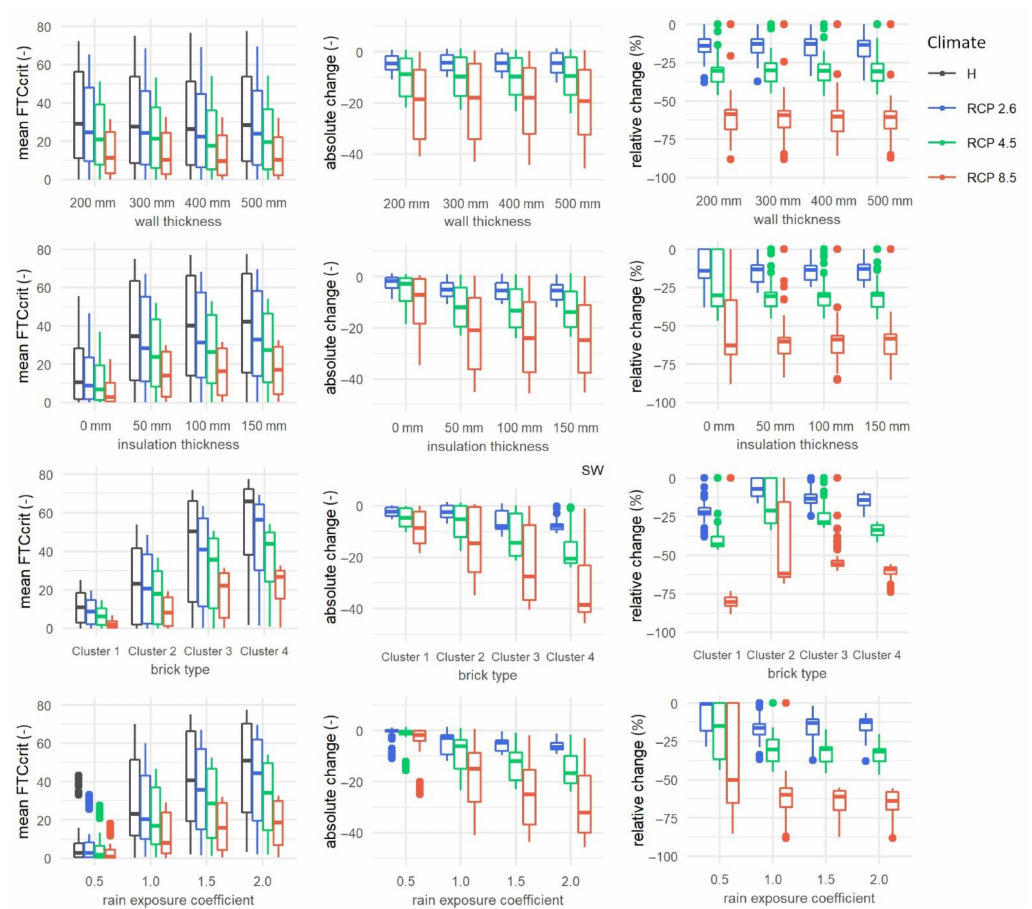
Figure 5. Mean value, mean absolute and mean relative change in FTC crit for the SW orientation per parameter variation: wall thickness, brick type, insulation thickness and rain exposure